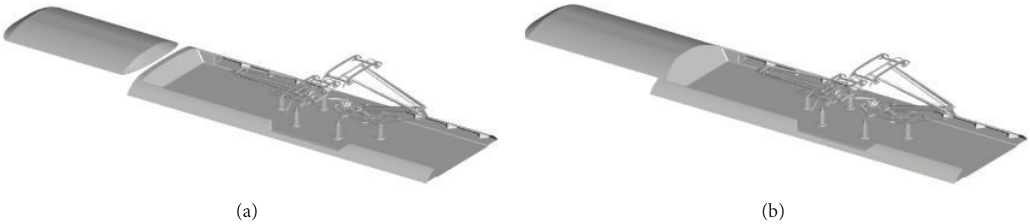
Figure 19: Two different pantograph fairing structures: (a) Dlz2 and (b) Dlz3.